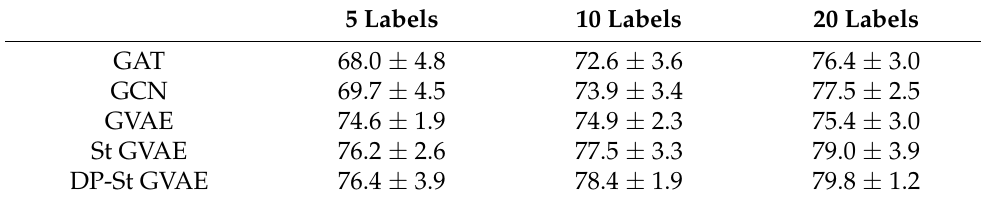
Table 7. Semi-supervised node classification prediction accuracy for